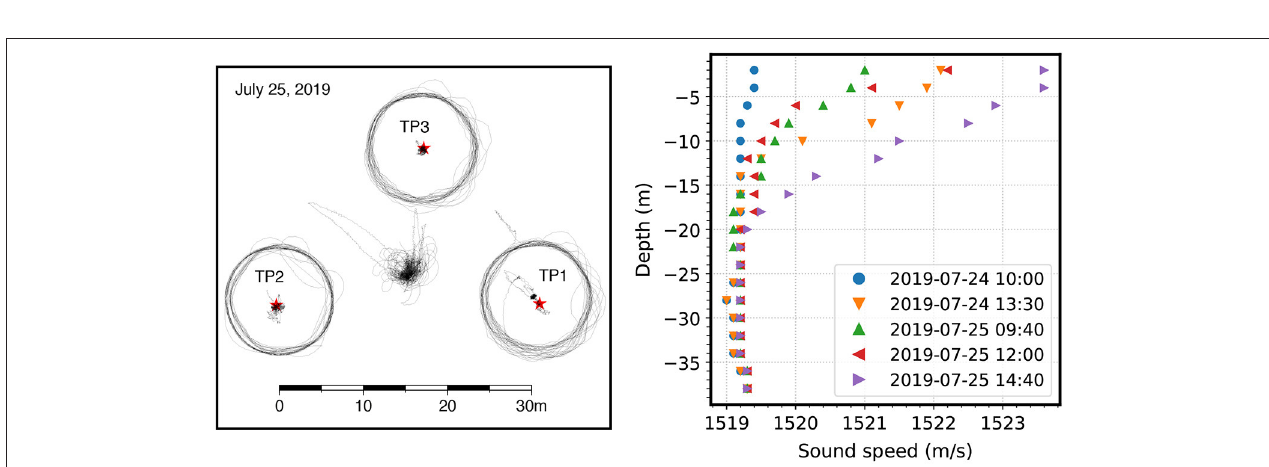
FIGURE 4 | (Left) Data acquisition trajectories of the USV during Day 2, including box-in circles and stations above or slanted relative to the transponders (TP, red stars). (Right) Sound-speed profiles acquired during the experiment.